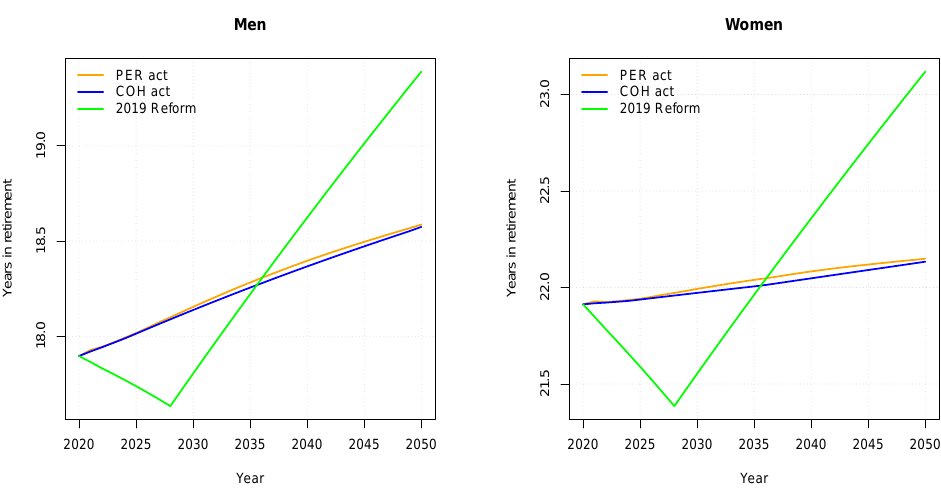
Figure 11. SVK: Expected years in retirement for each sex based on period and cohort